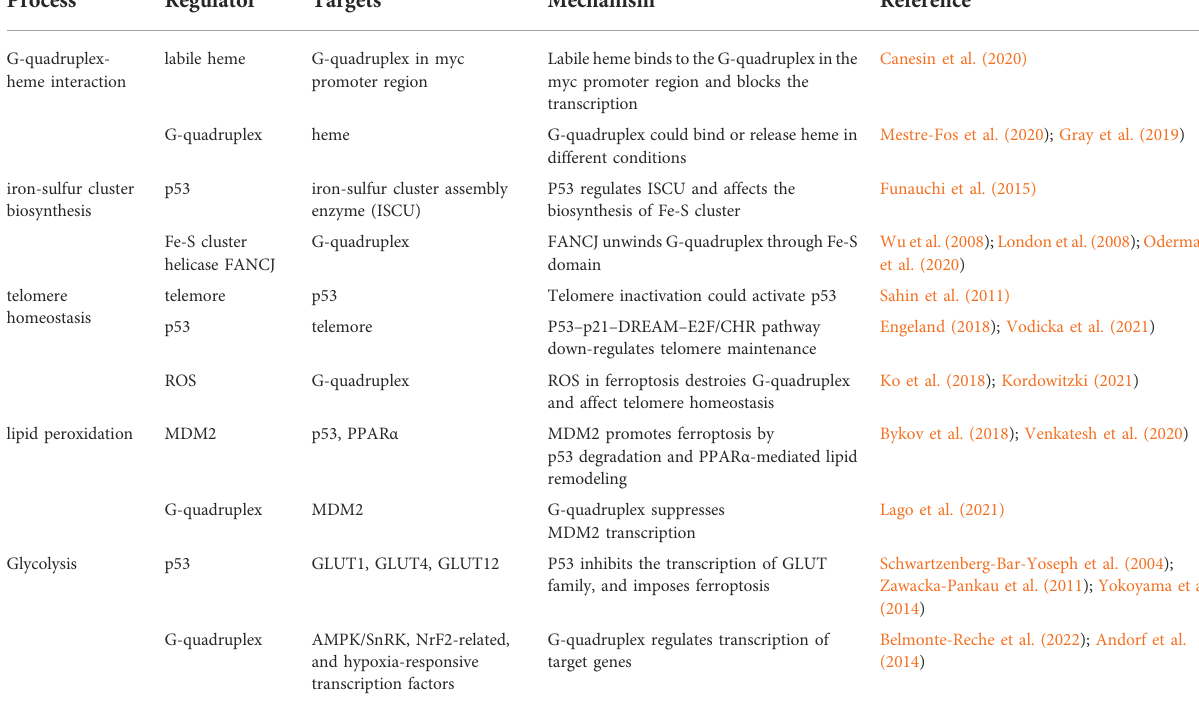
TABLE 1 The regulation and mechanism in ferroptosis related to G-quadruplex and